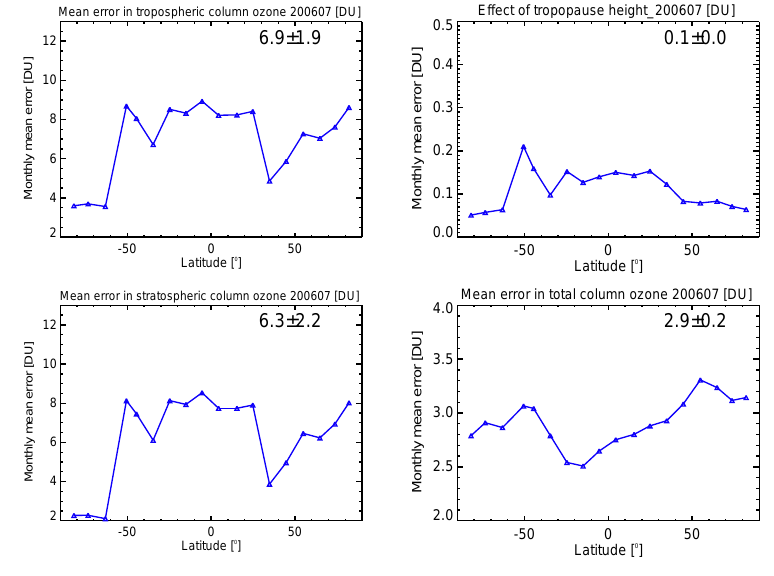
Figure 4. As Fig. 3 but for July